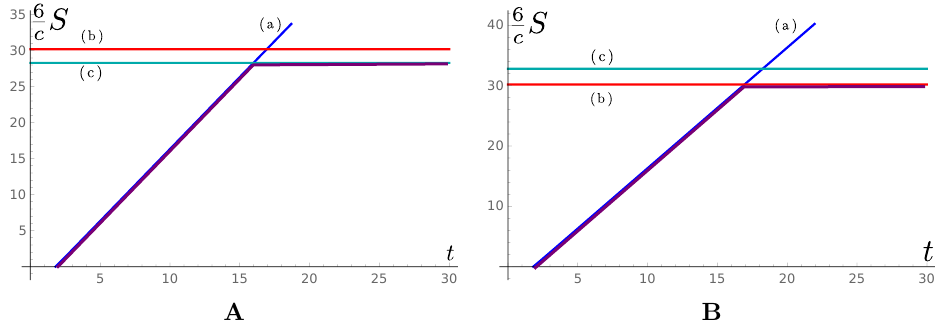
endpoints r = r 2 , 3